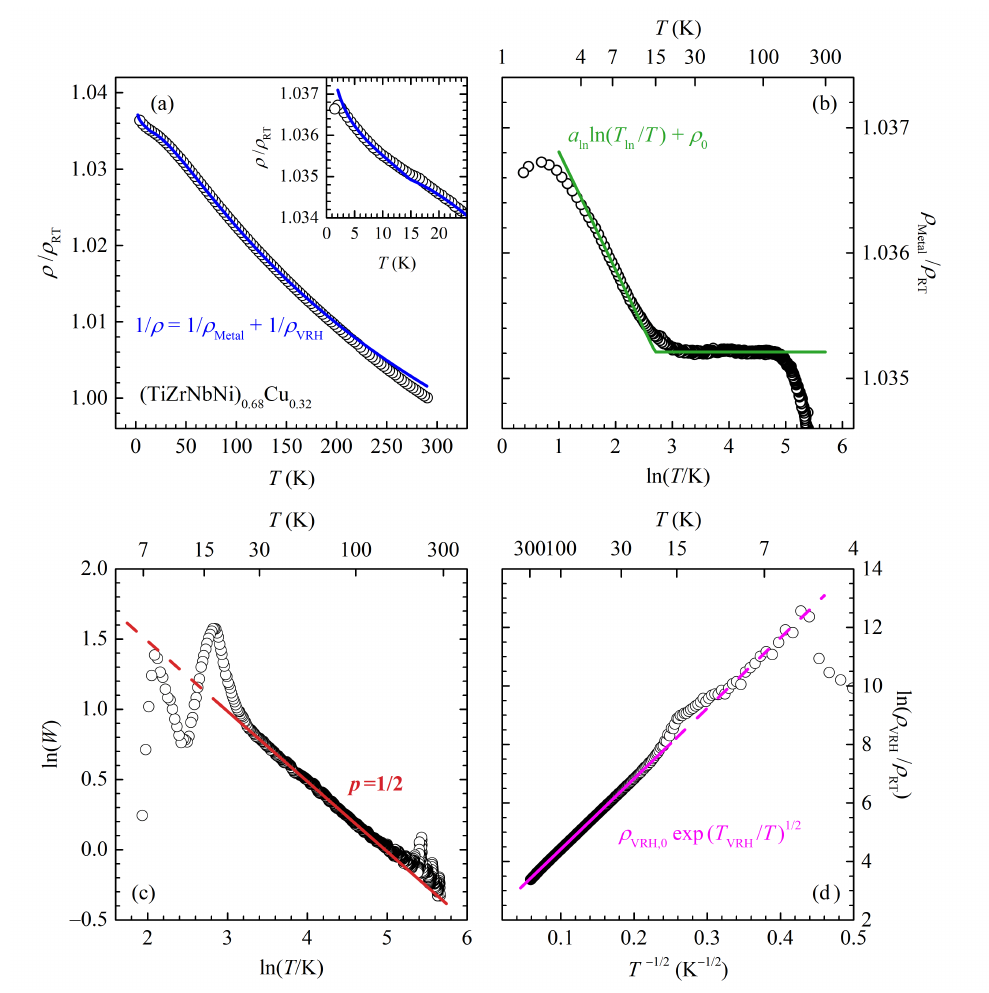
Figure 3. The results of fitting the measured temperature dependence of the Cu 0.32 alloy resistivity to the model with two parallel conductance channels. The points are measured data, and the lines are fits. See the text for details. ( a ) The temperature dependence of the normalized resistivity ρ / ρ RT . Inset: low-temperature detail of the main panel. ( b ) The temperature dependence of the metallic part ρ Metal ( T ) / ρ RT . ( c ) The ‘special logarithmic derivative’ plot of the VRH-like contribution of the resistivity (see Equation (4)) with a p = 1/2 slope. ( d ) Plot of the VRH-like contribution ln ( ρ VRH / ρ RT ) √ T vs. 1/